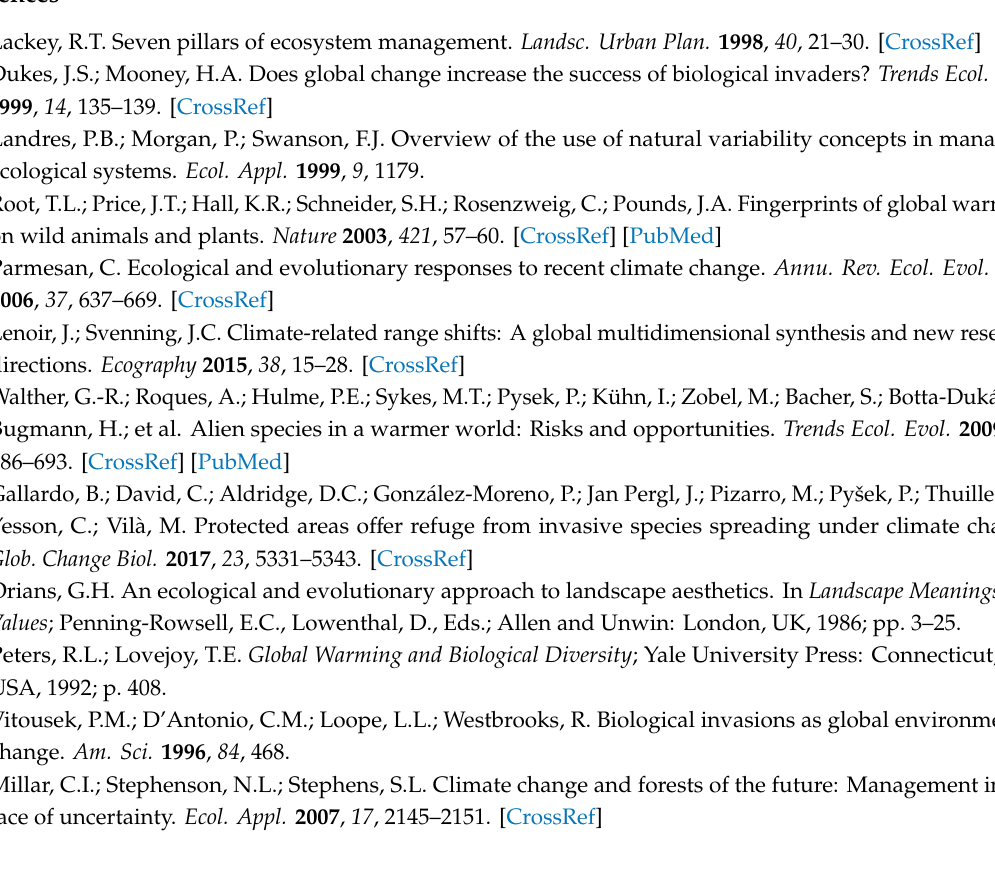
Table S1: Evaluation of distribution models / algorithms (mean values) in Pico Island by the true skill statistic (TSS) and the receiver operating characteristics curve (AUC), using two di ff erent EGV sets; Table S2: Evaluation of distribution models / algorithms (mean values) in Terceira Island by the true skill statistic (TSS) and the receiver operating characteristics curve (AUC), using two di ff erent EGV sets; Table S3: Evaluation of distribution models / algorithms (mean values) in S ã o Miguel Island by the true skill statistic (TSS) and the receiver operating characteristics curve (AUC), using two di ff erent EGV sets; Figure S1: Mean values of relative explanatory variables used to predict the distribution of P. undulatum (PU), in Pico, Terceira and S ã o Miguel islands. Mean values correspond to EGV set 2; Figure S2: Mean values of relative explanatory variables used to predict the distribution of A. melanoxylon (AM) in Pico, Terceira and S ã o Miguel islands. Mean values correspond to EGV set 2; Figure S3: Mean values of relative explanatory variables used to predict the distribution of M. faya (MF) in Pico, Terceira and S ã o Miguel islands. Mean values correspond to EGV set